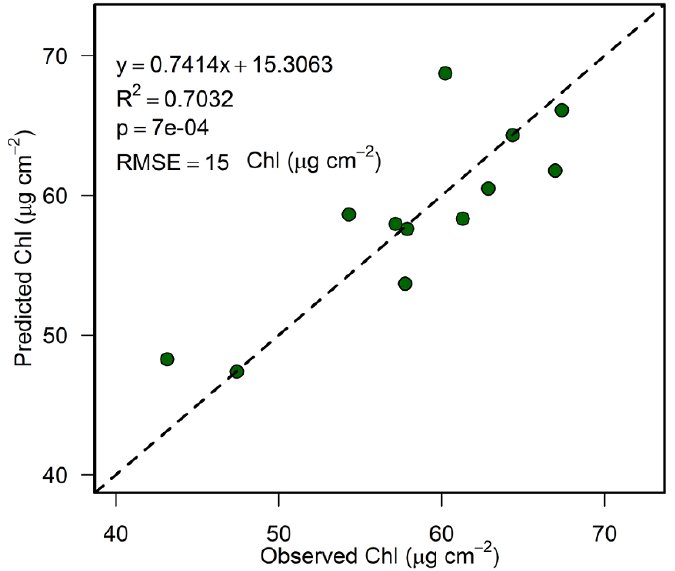
Figure 8. Observed against predicted CC using the leave-one-out cross-validation method. Each point represents an ESU. RMSE =15 μ g·cm − 2 , R 2 =